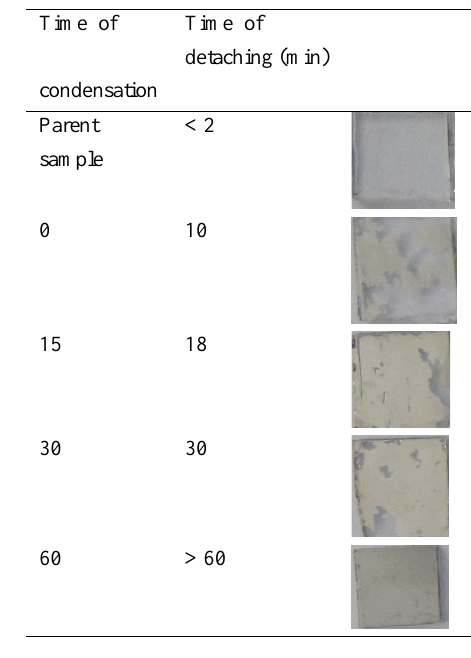
Table 2. Stability test of the original state and silanized